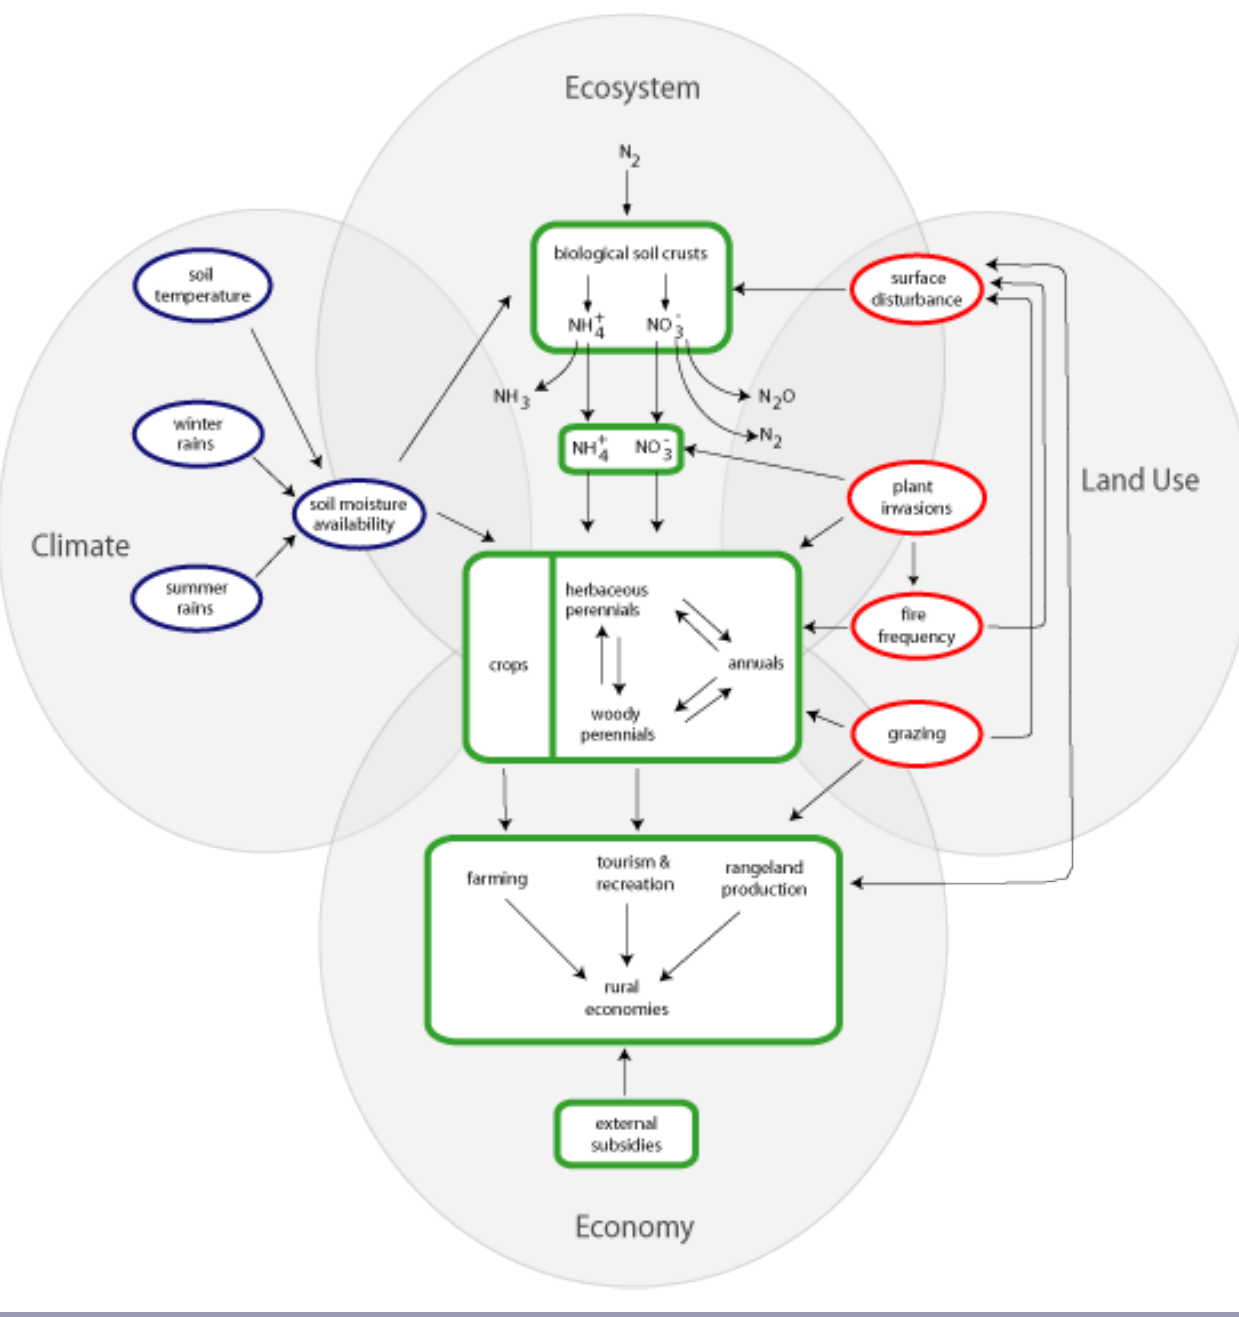
Fig. 3. Interactive pathways between climate, ecosystem, land use, and economy (see text for